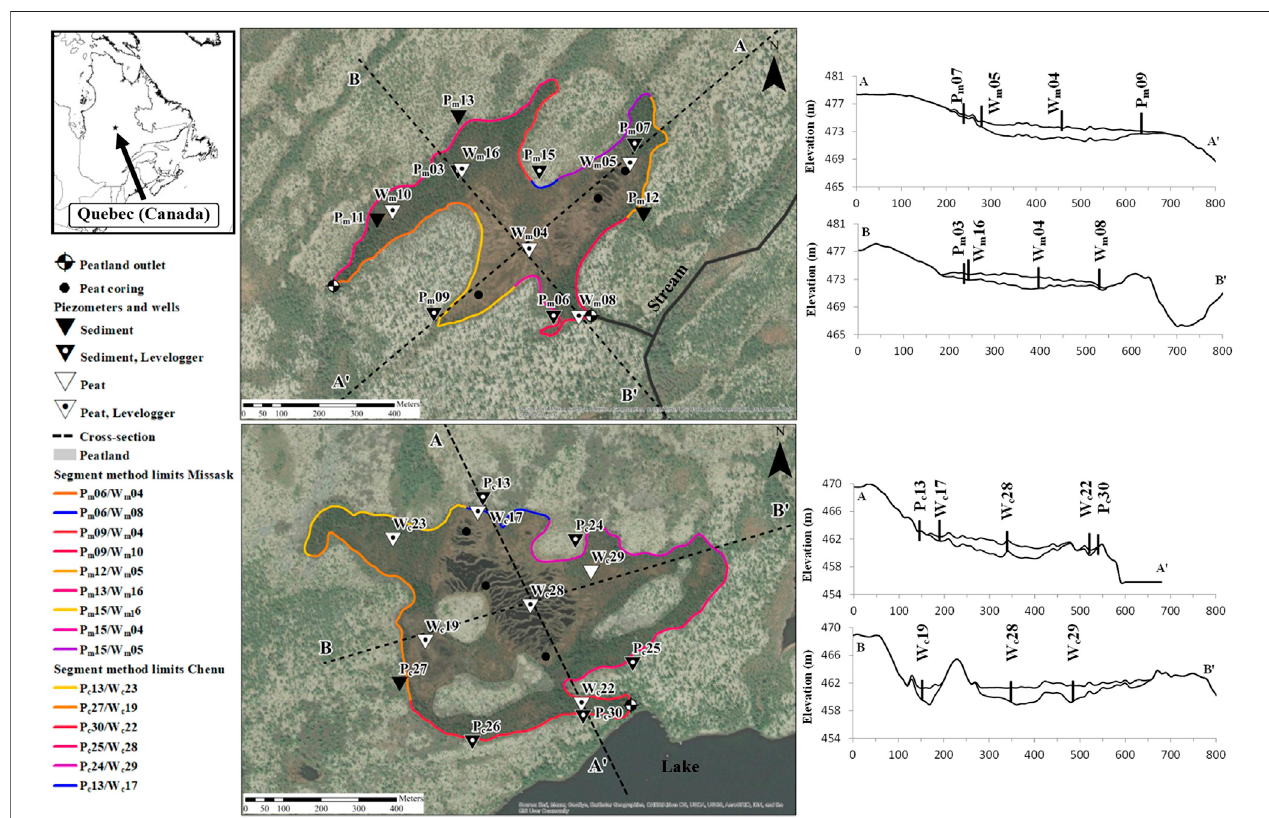
FIGURE1| Locationofthestudiedpeatlands,locationofwells(W)andpiezometers(P),contoursectionsusedintheDarcy fl owcalculation,andpeatlandtransects at a) the Misask (m) peatland and b) the Cheinu c) peatland.